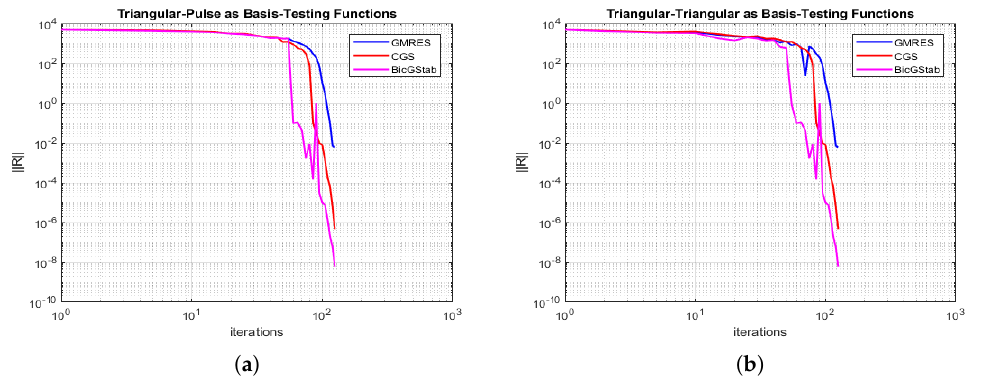
Figure 11. (cid:107) R (cid:107) vs. number of iterations for GMRES. CGS and BicGStab algorithms: ( a ) triangular–pulse ( b ) triangular–triangular functions as basis-testing